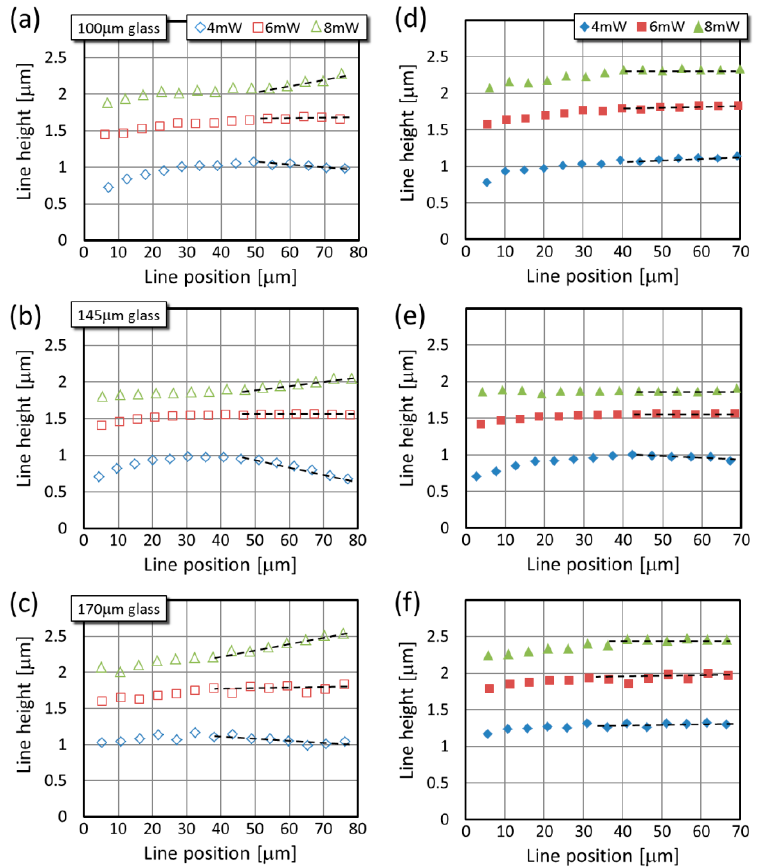
Figure 5. Typical line height values as the function of the position over the glass surface for three glass sizes. Panels ( a – c ) are from uncorrected lines, while panels ( d – f ) are from SA-corrected ones. The dashed lines are to guide the eye and to highlight the most prominent change upon the correction.